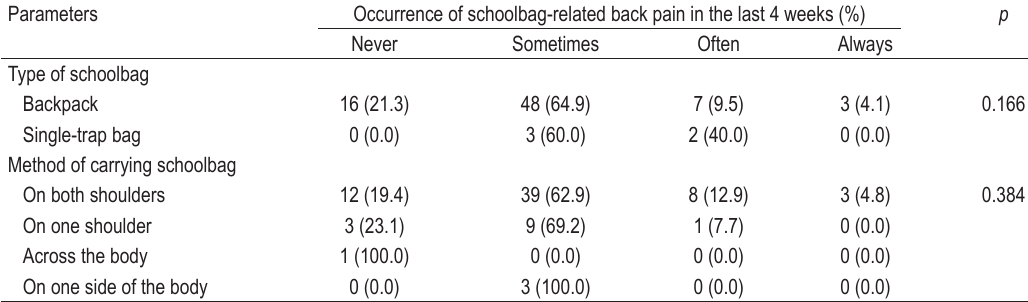
TABLE 10. Type of schoolbag and method of schoolbag carrying in relation to back pain Parameters Occurrence of schoolbag‑related back pain in the last 4 weeks